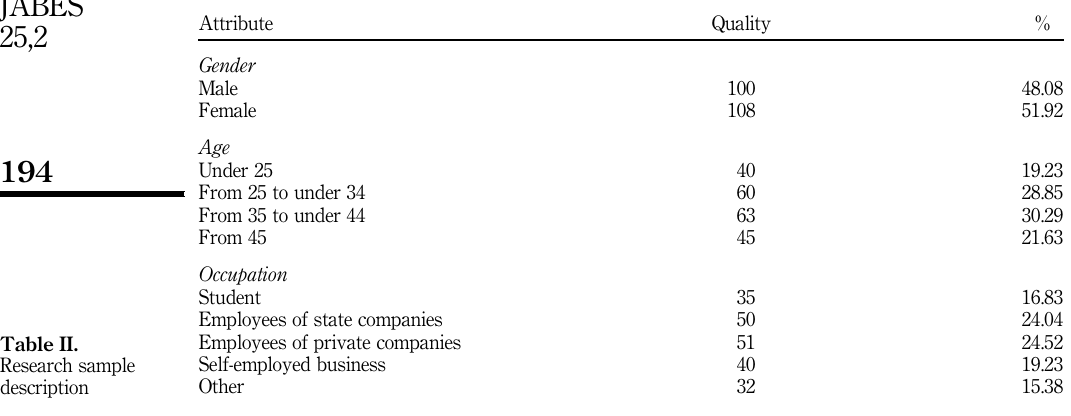
Table II. Research